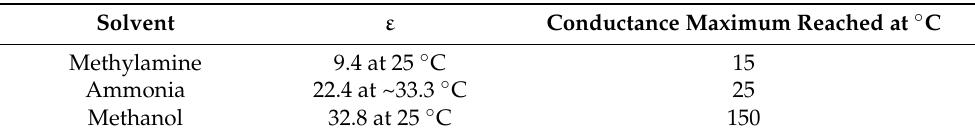
Table 13. The temperature at which the highest conductance value is reached for potassium iodide in solvents of different ε values: methylamine, ammonia and methanol. Adapted from [19] American Chemical Society,